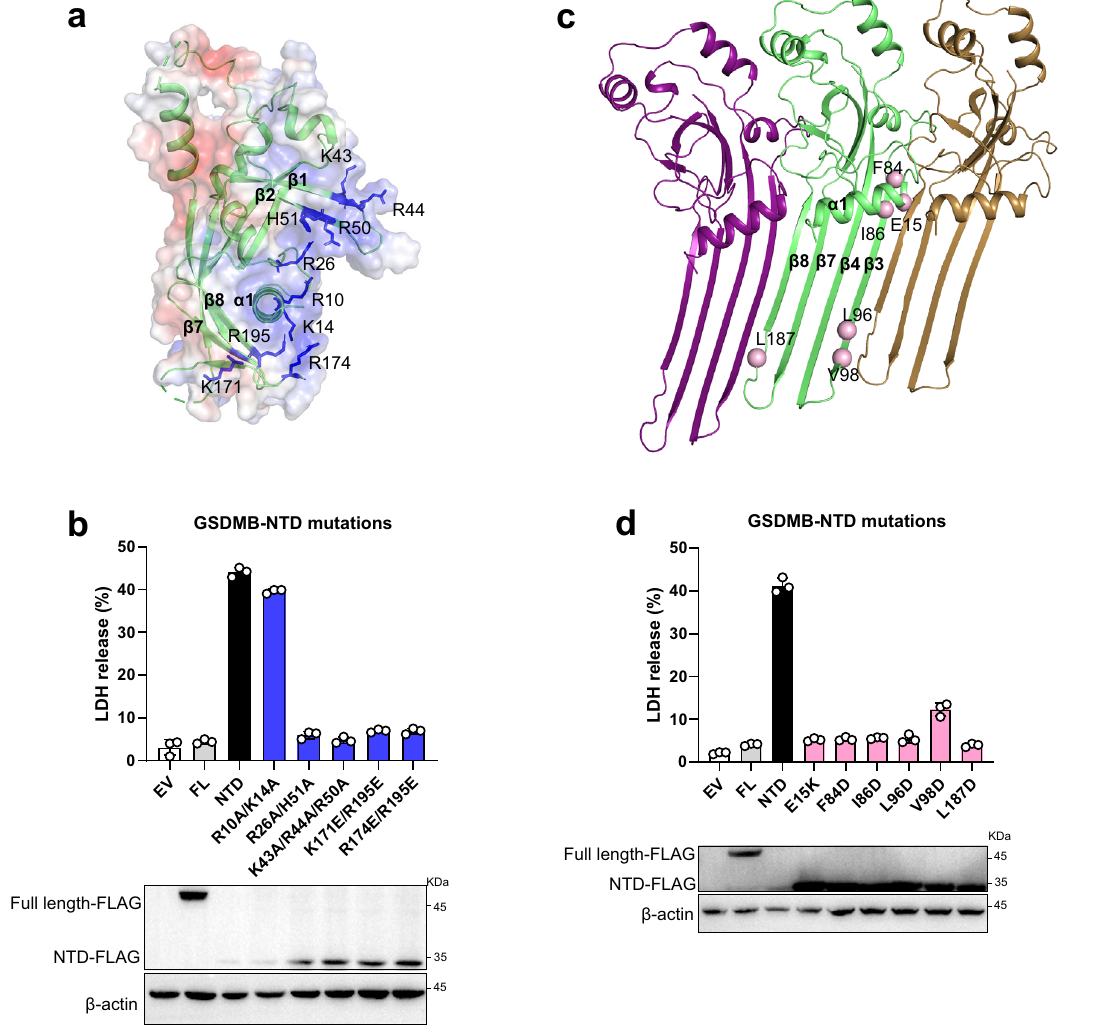
of GSDMB proteins. c Pore model of NTD-GSDMB. The residues in the oligomer- ization interface selected for mutation are shown in pink sphere representations. d Mutations of the residues in the oligomerization interface reduced the NTD- mediated LDH release. All experiments were repeated at least three times (mean±sd, n =3 independent biological replicates). Bottom, the expression levels of GSDMB proteins. Source data are provided as a Source Data fi